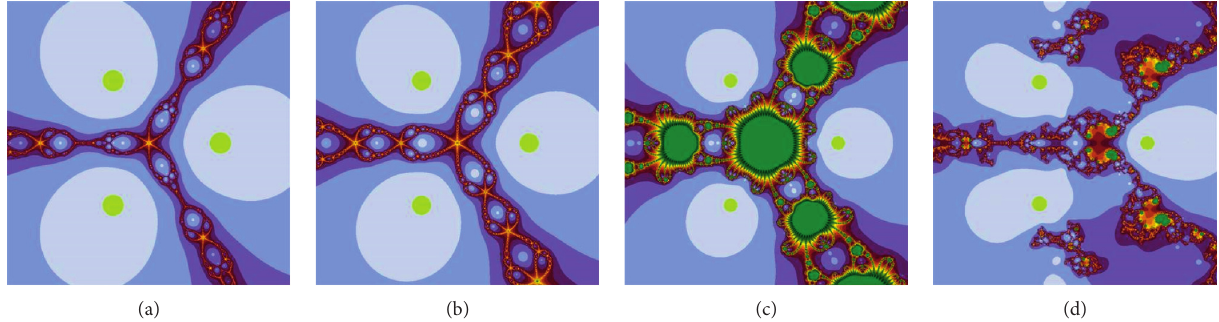
Figure 2: Polynomiographs related to the complex polynomial q (d) Algorithm 1.